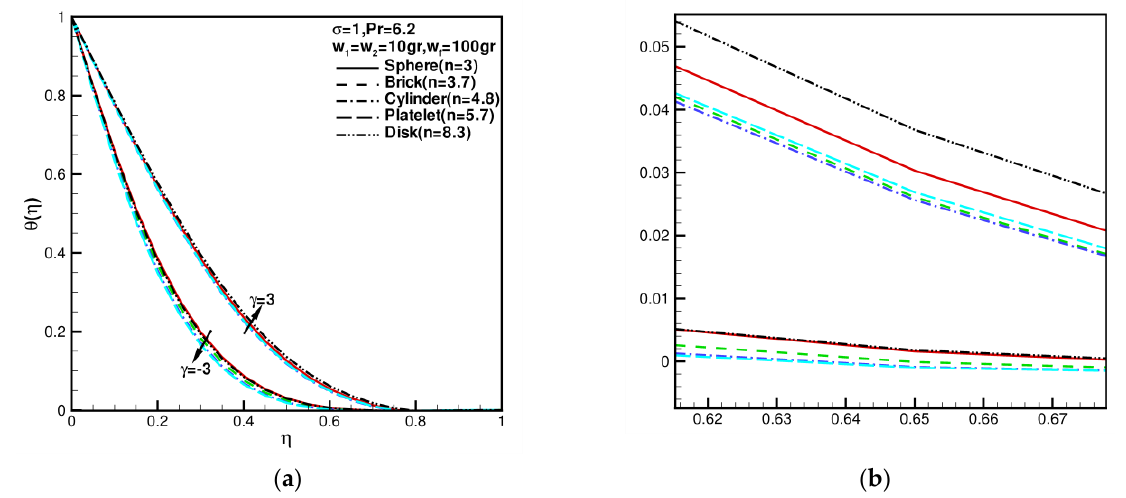
Figure 4. The dimensionless velocity components f (cid:48) ( η ) , g (cid:48) ( η ) against shape factor n when w 1 = w 2 = 10 gr, w f = 100 gr, σ = 1, Pr = 6.2, and γ = − 3, 3.